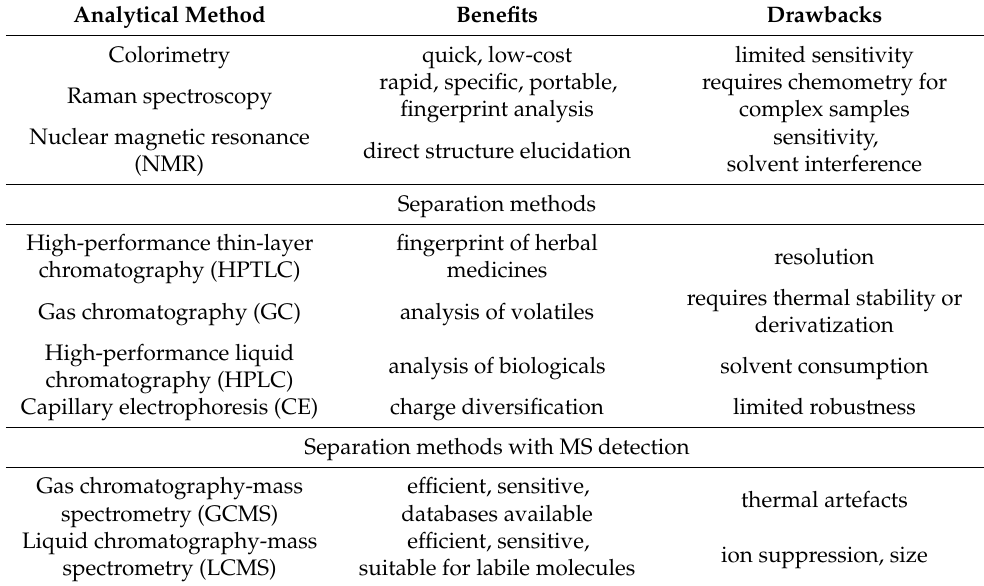
Table 1. Modern analytical methods used in medicinal drug inspection (based on